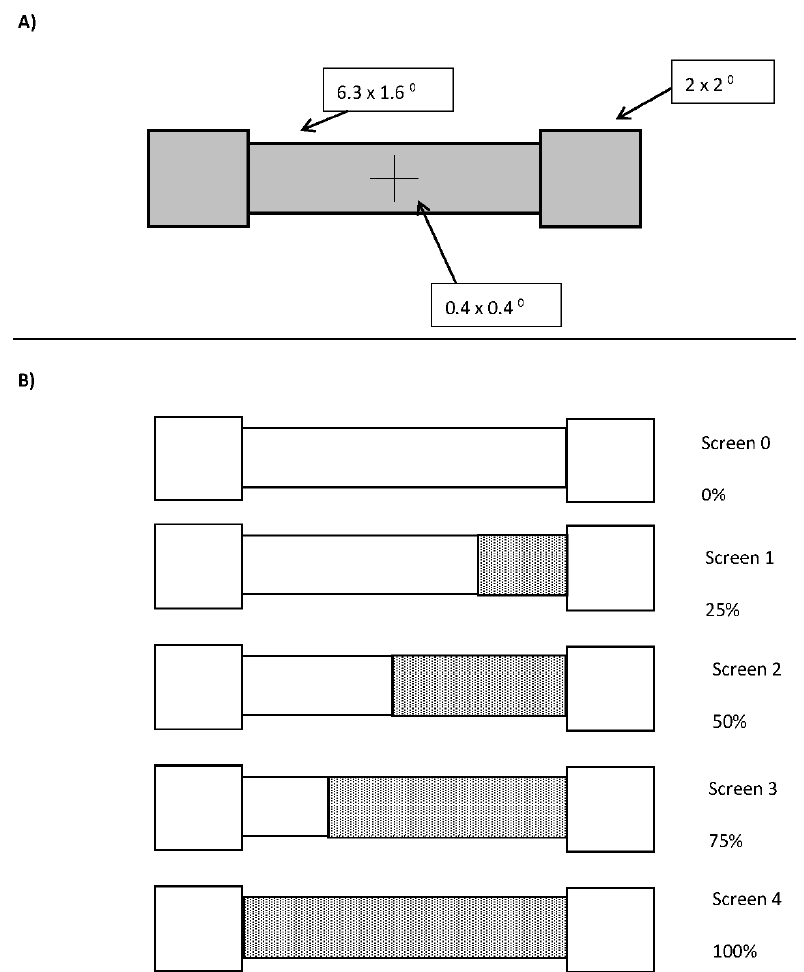
Figure 1. Schematic of A ) the stimulus display with measurements in degrees of visual angle and B ) the real leftward moving colour change at the slowest speed. The medium speed changed the bar in three segments, and the fast speed changed the bar in two segments. No motion changes the bar on a single screen refresh.